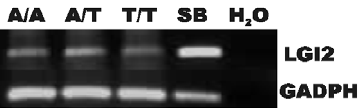
Figure 1. Mapping and identification of the benign focal juvenile epilepsy mutation in LagottoRomagnolo . A) Genome-wide association analysis maps the disease locus to CFA3 with the strongest association at a SNP at position 89,159,216 (P raw =0.000035 and P genome-wide =0.08). B) A 1.7 Mb homozygous block spanning from 87.3 Mb to 89.0 Mb is present in affected dogs (bottom set of 11 dogs) and not in unaffected dogs (top set of 11 dogs). C) Sequencing of the Lgi2 coding regions revealed a homozygous c.1552A . T mutation that causes a premature stop codon in exon 8, resulting in truncation of the last 12 amino acids in the affected cases.